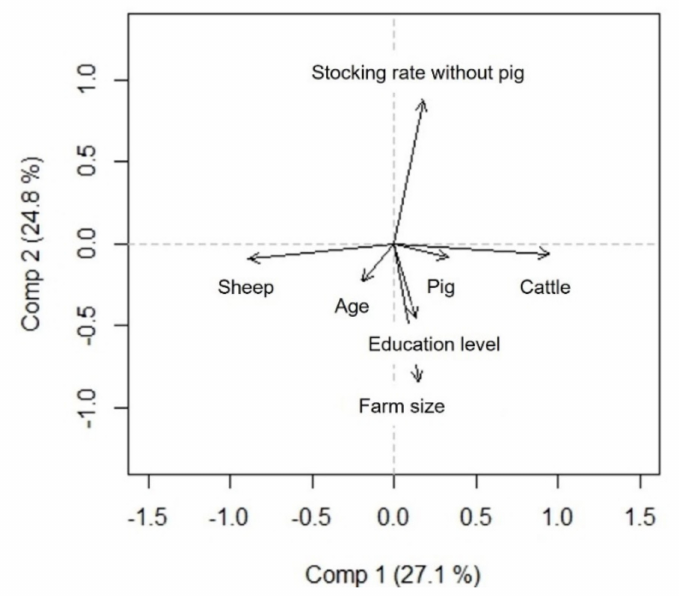
Figure 1. Loadings plot from categorical principal component analysis of structural variables.